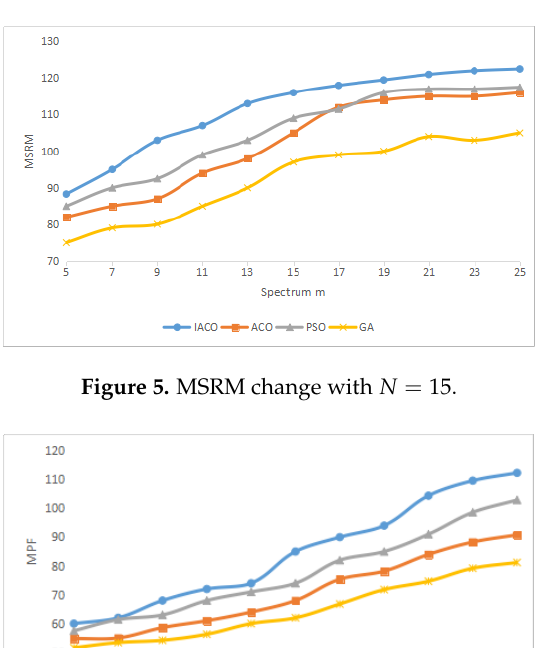
Figure 4. The average system benefit with increasing of iterations.